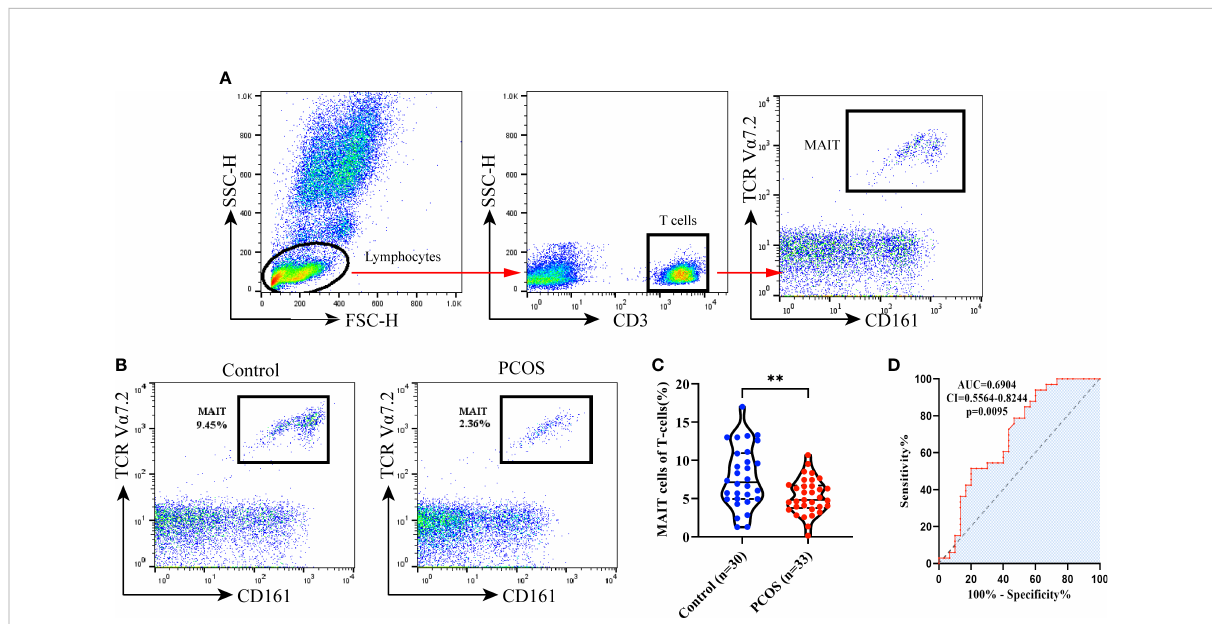
FIGURE 1 Frequency of MAIT cells in controls and PCOS patients. (A) Gating strategy for identi fi cation of circulating MAIT cells (CD3+ TCRV a 7.2+CD161+). (B) Representative fl ow plots show the MAIT cells gated among CD3+ T cells in control and PCOS patients. (C) The frequency of MAIT cells in PCOS patients (n = 33) was signi fi cantly decreased compared to control (n = 30) (p<0.01). Data represent means ± SEM, **p < 0.01, signi fi cantly downregulated compared to control which analyzed by Mann – Whitney U test. (D) ROC curves of the MAIT cells in the identi fi cation of the PCOS patients (the area under the curve (AUC), con fi dence interval (CI), and the associated calculated P-value (p) are indicated on each